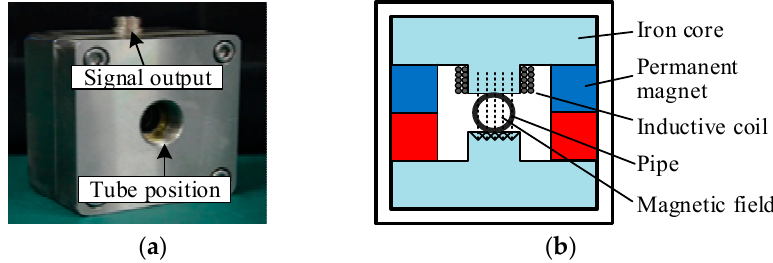
Figure 1. Radial magnetic field-based debris sensor: external ( a ) and internal ( b ) structure.